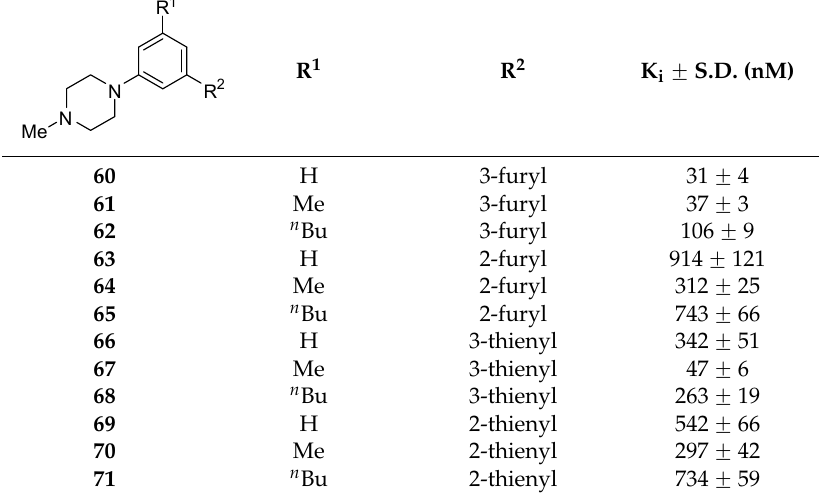
Table 6. Extended results for compounds 12 and 13 .